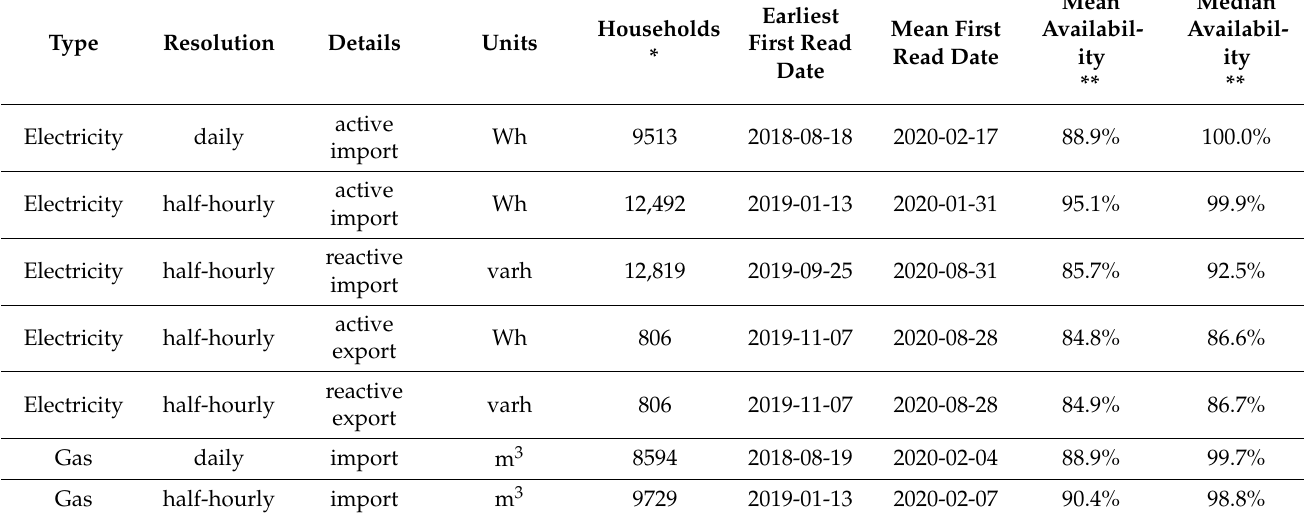
Table 2. Summary of smart meter data availability by read type for the SERL Observatory sample. By ‘available’ we mean the read exists as expected and is valid according to our criteria (see below). * Households gives the number of households in the sample with at least one valid read. ** Mean (or median) of the data availability for each